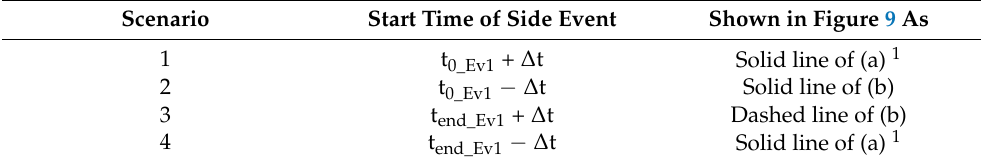
Table 1. Potential scenarios derived from Figure 9a.